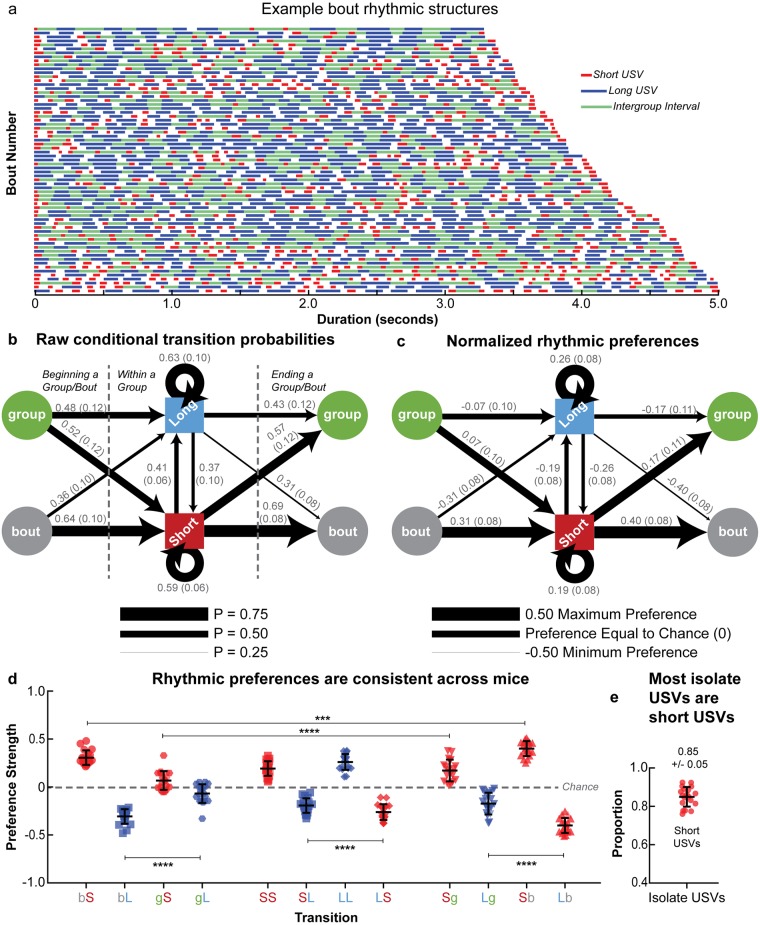
Series rhythmic structure is consistent across mice.(a) Example bouts produced by an adult mouse. Bouts are stacked according to duration, with the shortest on top and the start of the bouts on the left. Red lines indicate short USVs, blue lines indicate long USVs, green lines indicate IGIs, and white spaces indicate IVIs, with the length of the lines and spaces representing to scale the duration of the USVs and ISIs. Mean (b) raw conditional probabilities and (c) normalized Preference Scores for each transition across all 19 mice. The numbers adjacent to the bars indicating the transition represent the mean across mice with the standard deviation in parentheses. Additional statistical details are presented in S11 and S12 Tables for (b) and (c), respectively. (d) Average Preference Scores for each transition in all 19 adult mice, depicting the values for individual mice. (e) Proportion of isolate USVs observed to be short USVs. In (d) and (e), error bars indicate the mean across animals +/-1 standard deviation, and values for individual mice are represented by the 19 overlaid points. In (b-c), IGIs are represented by the green circles while IBIs are indicated by the grey circles. In (d), “b”, “g”, “S”, and “L” correspond to IBIs, IGIs, short USVs, and long USVs, respectively.